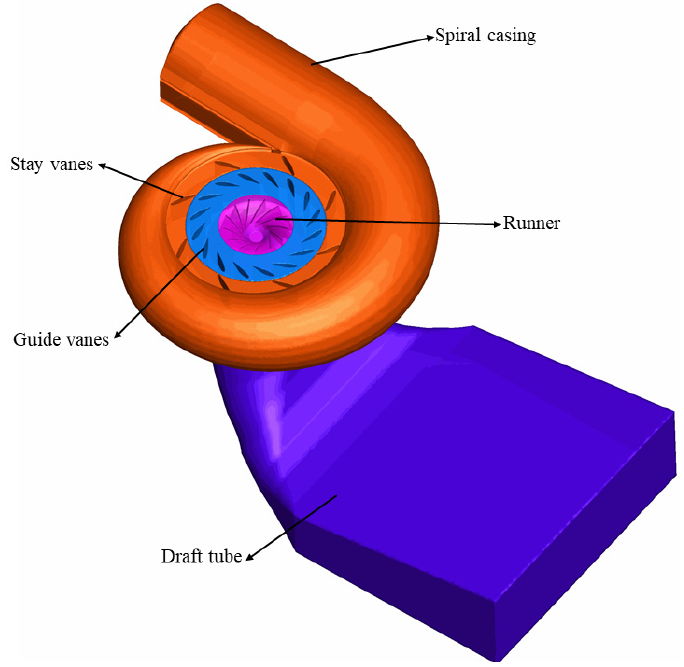
Figure 1. Calculation domain of Francis turbine.